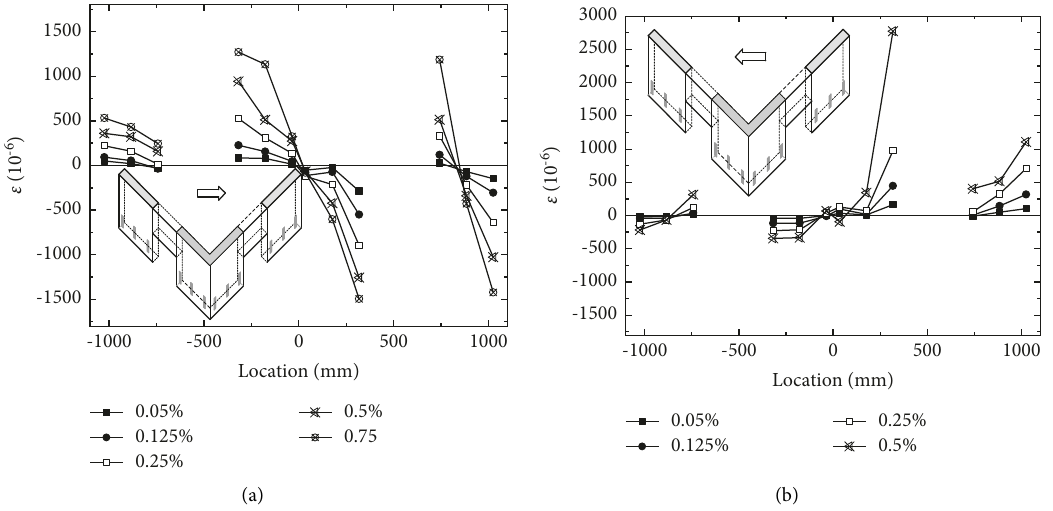
Figure 12: Wall limb strain distributions of CW4X-D. (a) Positive. (b)